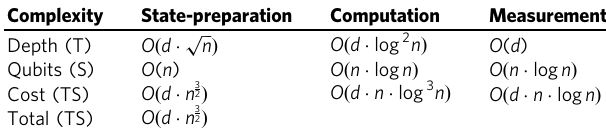
Table 2 Complexity of each step in hybrid quantum-classical computing for deep neural network with